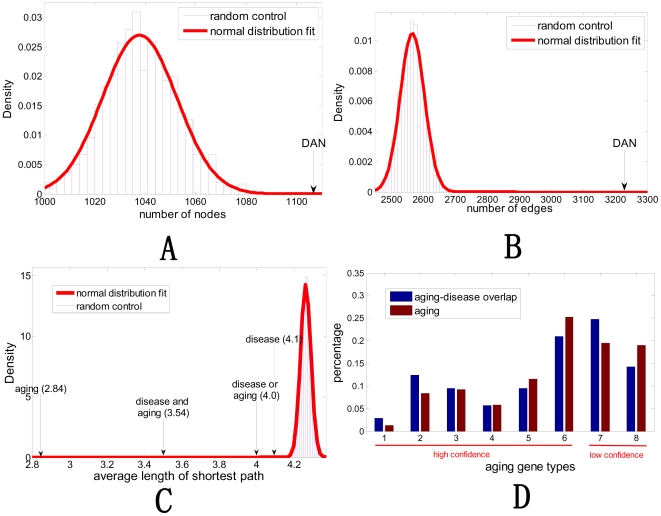
The further analysis of disease aging network (DAN).(A) The number of vertexes of DAN is significantly larger than that of degree-conserved random networks (p-value <1.0e-6). (B) The number of edges of DAN is significantly larger than that of degree-conserved random networks (p-value <1.0e-10). The procedure to generate the random networks is described in Materials and Methods. (C) Comparison of average lengths of shortest paths among aging genes, disease genes, aging or disease genes, aging and disease genes, and random genes in the human protein interaction network from HPRD database. The normal distribution is used to fit the distance between genes. (D) Classification of aging genes by their supporting evidences in GenAge database. All aging genes are classified into eight types (x-axis). Types 1–6 are supported by direct and high-confident evidences while Types 7 and 8 are supported by indirect evidences. Given a particular type of aging gene, the difference of its percentages (y-axis) in the aging-disease overlap gene set and whole aging gene set indicates whether or not the aging gene set possesses potential bias to diseases.